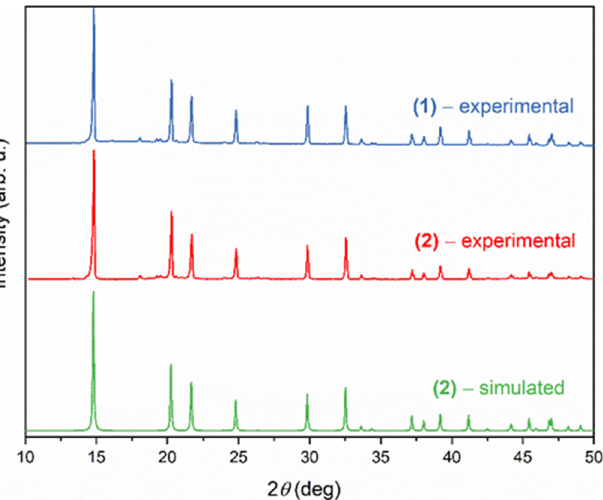
Figure 1. Experimental powder XRD patterns for DMAZnD (blue line) and DMAZnF (red line) compared to simulation, based on structural data presented for DMAZnF taken from [22].